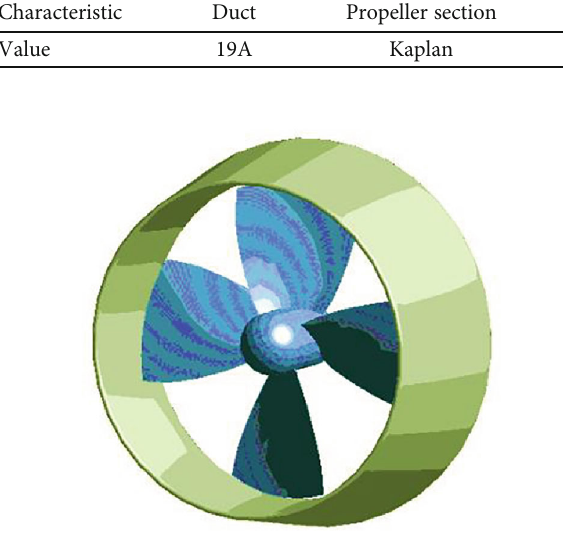
Table 1: Geometric speci fi cations for ducted propeller ka 4-70 [3]. Characteristic